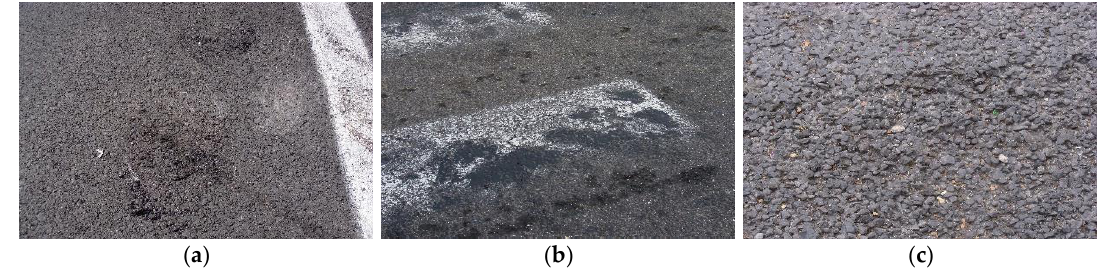
Figure A3. Failed surface grip. ( a ) Low Severity; ( b ) Medium Severity; and ( c ) High Severity.